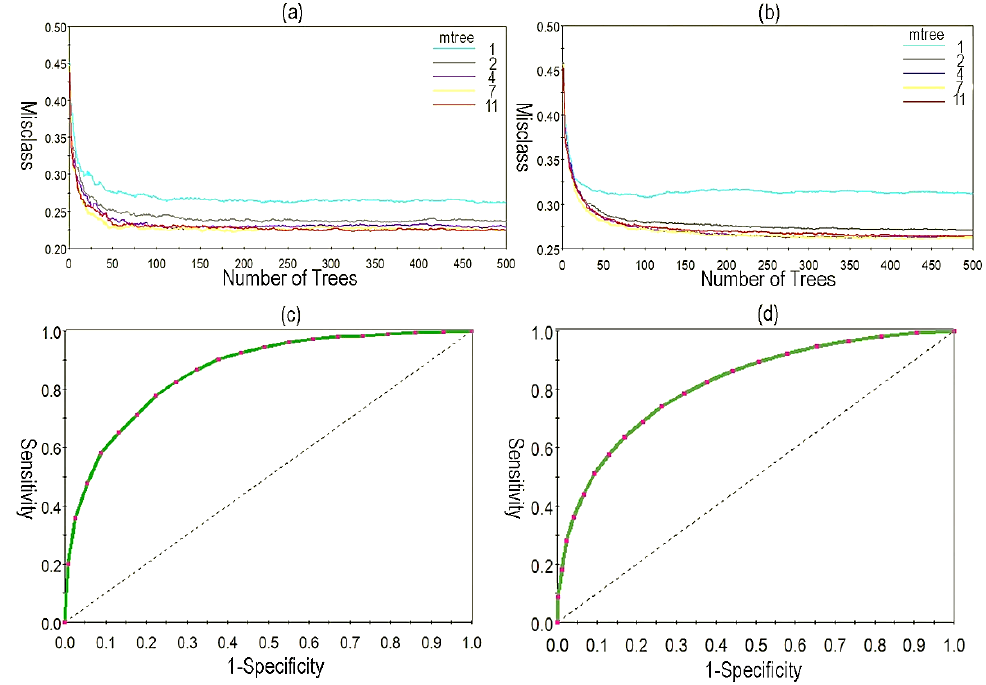
Figure 3. The optimal number of trees and the number of variables for splitting in each tree of the random forest based on the minimum misclassification error for mapping landslide susceptibility in the protected forest ( a ) and non-protected forest ( b ); the area under the ROC curve obtained from the out-of-bag error for testing the performance of random forest for mapping landslide susceptibility in the protected forest ( c ) and non-protected forest ( d ) in NE